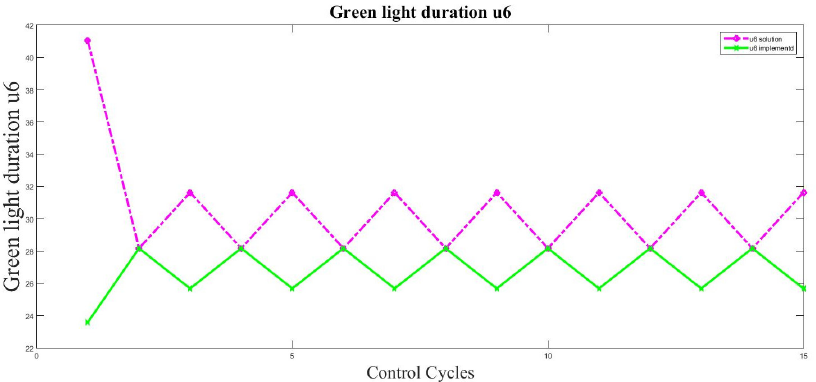
Figure 8. Difference between the evaluated and implemented green light duration u 6 .